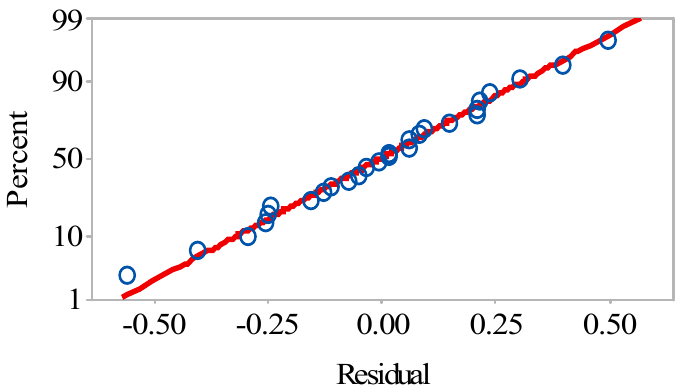
Figure 6. The normal probability plot for the response (fc).